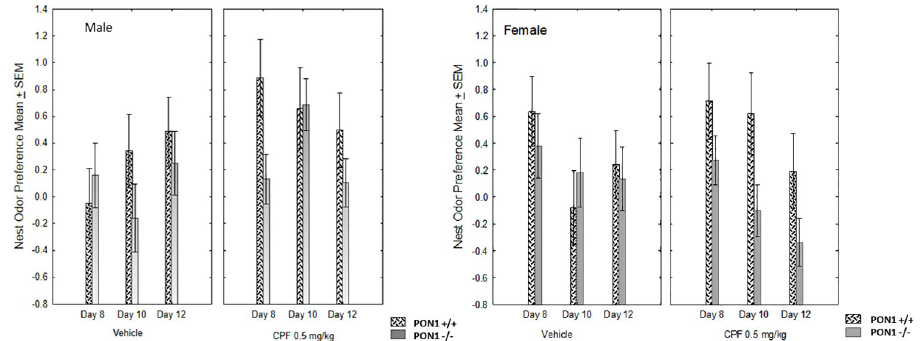
Fig 7. Nest Odor Preference (NOP) score (Mean + SEM) compared to unsoiled bedding in PON1 +/+ and PON1 -/- mice born to dams treated on GD12-15 with either oil (vehicle) or CPF. Pups were tested on postnatal days 8, 10 and 12. NOP was lower in PON1 -/- mice (p < .005) compared to PON1 +/+ mice. PON1 -/- mice exposed on GD 12–15 to CPF had a lower NOP score than PON1 +/+ mice exposed prenatally to CPF (p < 0.05). The number of pups per group is given in the legend to Fig 4; however, in this experiment na ï ve pups from the same litter were tested.